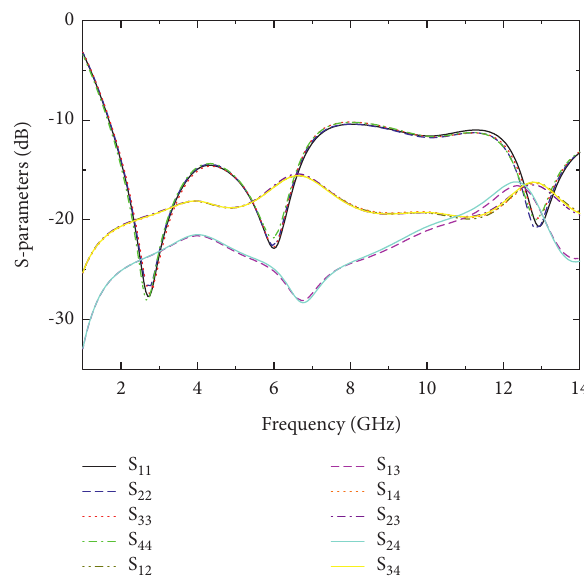
Figure 11: Schematic diagram of the structure of the four-port UWB MIMO antenna (mm).